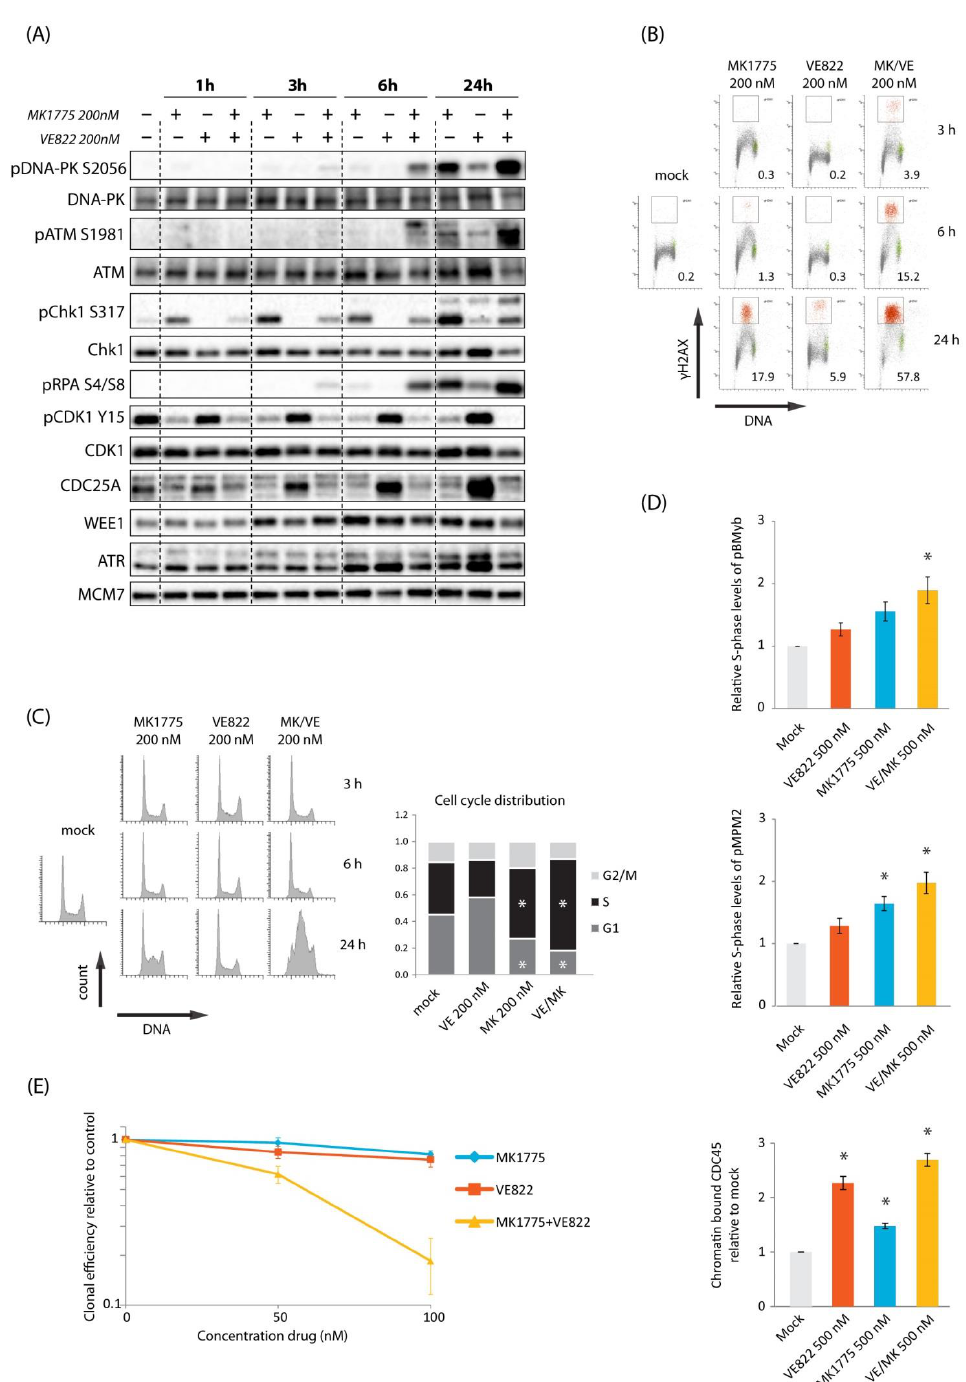
Figure 1. Synergistic induction of S-phase DNA damage and cell killing in U2OS cells upon combined WEE1/ATR inhibition. ( A ) Immunoblotting of extracts from U2OS cells treated with MK1775 (200 nM) and VE822 (200 nM) as indicated. ( B ) Flow cytometry analysis of U2OS cells treated with MK1775 (200 nM) and/or VE822 (200 nM) for 3, 6, and 24 h or left untreated (mock). Scatter plots of γ